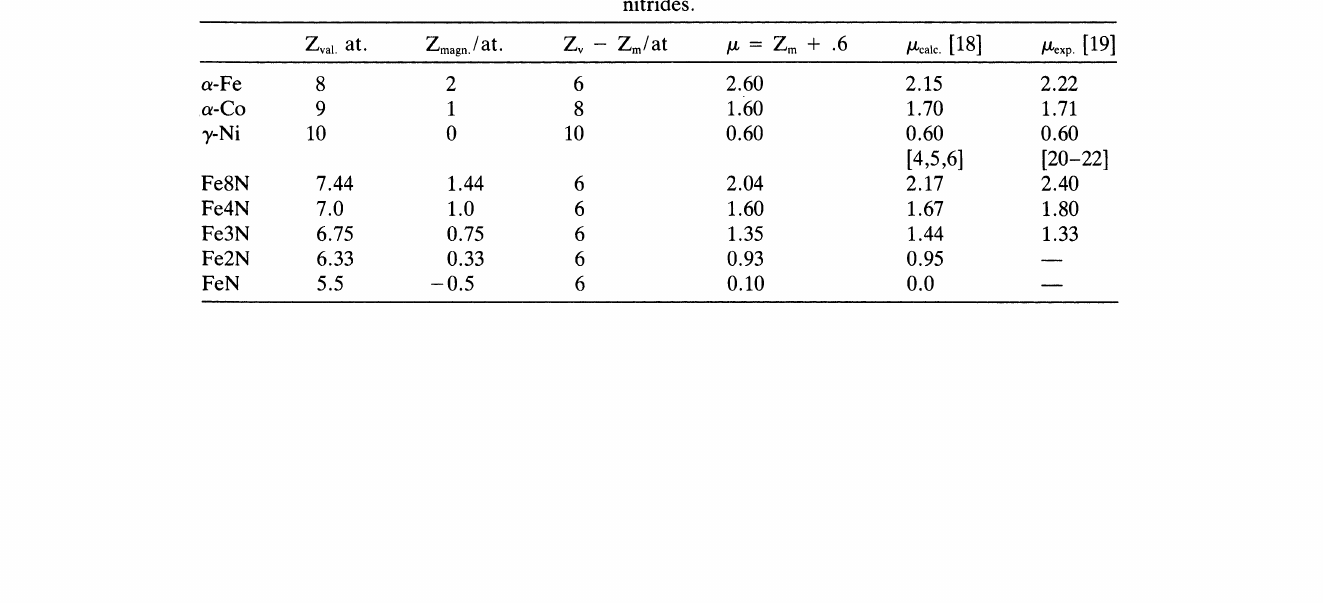
Magnetic and valence electron counts and magnetic moments for 3d elemental magnets and iron nitrides. Zval.